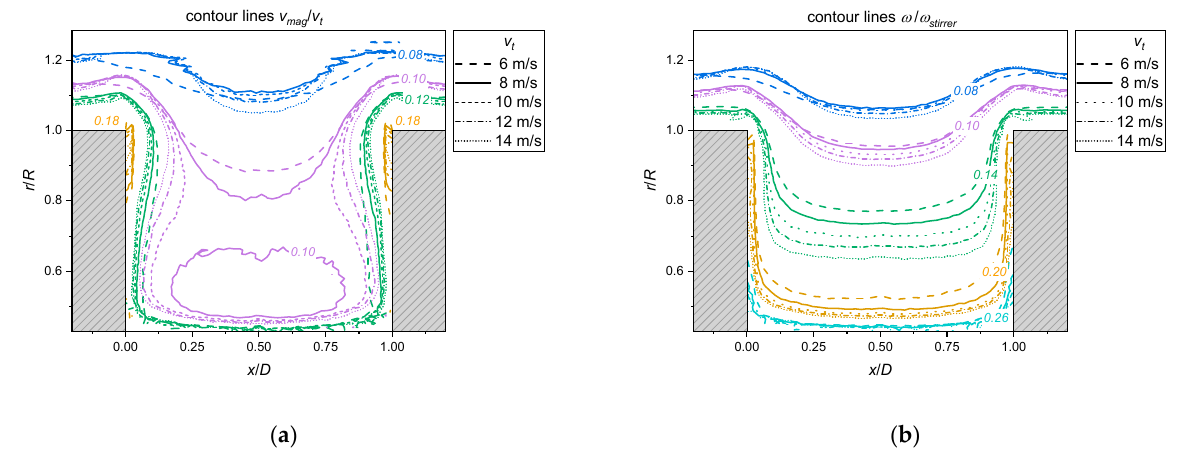
Figure 6. View in the axial section for different stirrer tip speeds at a grinding media filling level of 80%: ( a ) local normalized mean grinding media velocity, where the dark ‐ blue, lilac, green and yellow lines represent the 0.08, 0.10, 0.12 and 0.18 contour lines, respectively; ( b ) local normalized mean angular velocity of the grinding media around the shaft, where the dark ‐ blue, lilac, green, yellow and bright ‐ blue lines represent the 0.08, 0.10, 0.14, 0.20 and 0.26 contour lines, respectively.